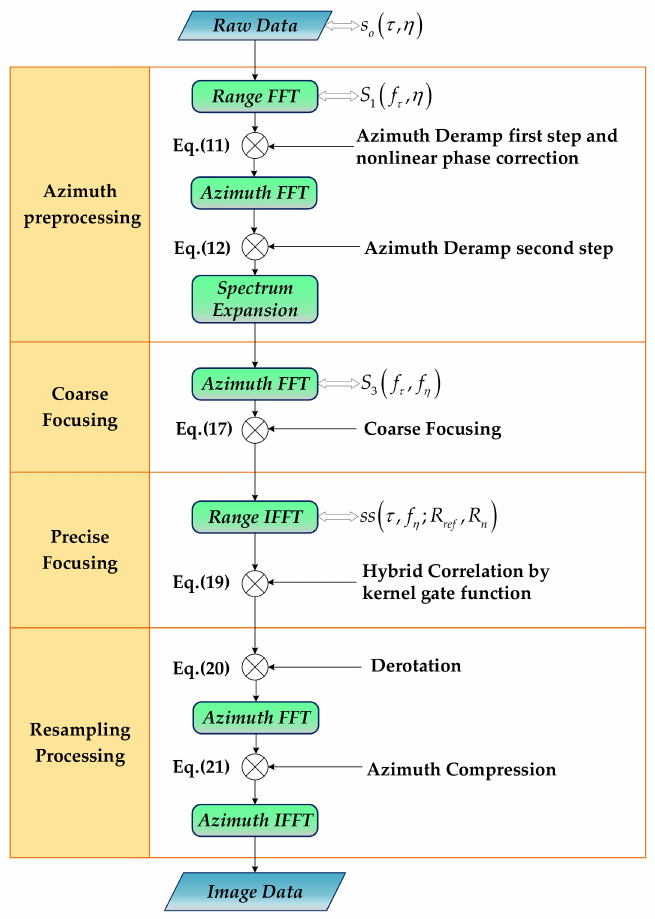
Figure 9. Flowchart of proposed squint mode of HEO SAR imaging